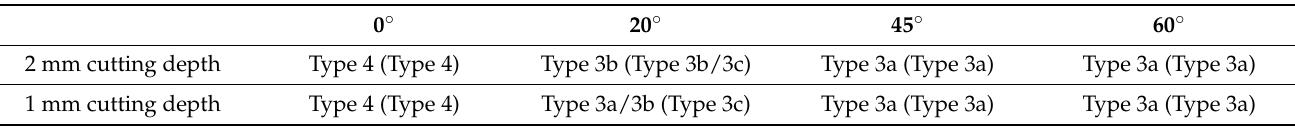
Table 6. Predominant steady-state chip types that occurred for each of the cutting parameters for the high-speed orthogonal cutting of PU20. Note: Experimental (CFI